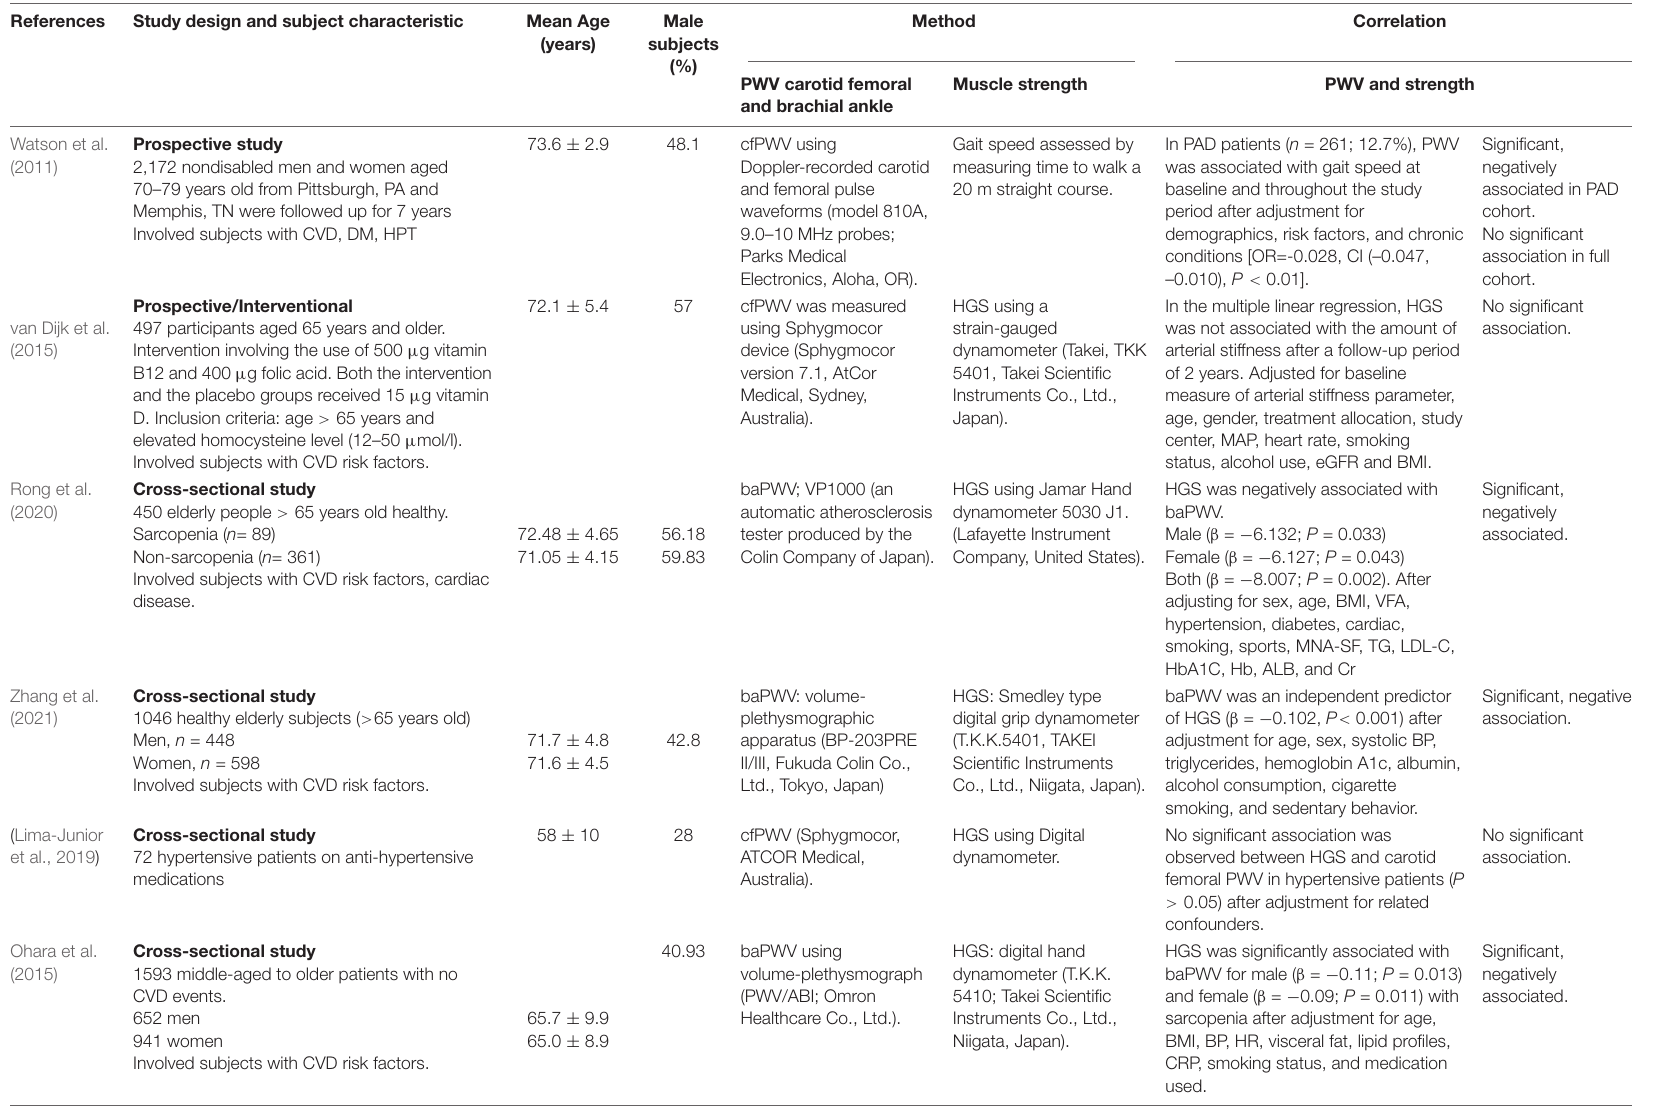
TABLE 2 | Selected studies focusing on the association between arterial stiffness and muscle strength in subjects with cardiovascular diseases or cardiovascular diseases risk